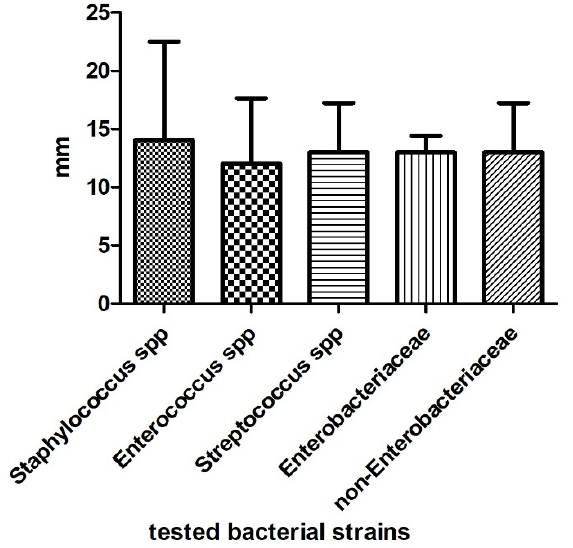
Figure 1. Graphic representation of average growth-inhibition-zone diameters (mm) obtained for the tested strains in the presence of silver-nitrate antiseptic solution of 1/6000 concentration.